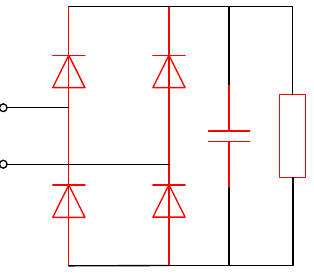
Figure 10. Uncontrollable rectifier bridge load.